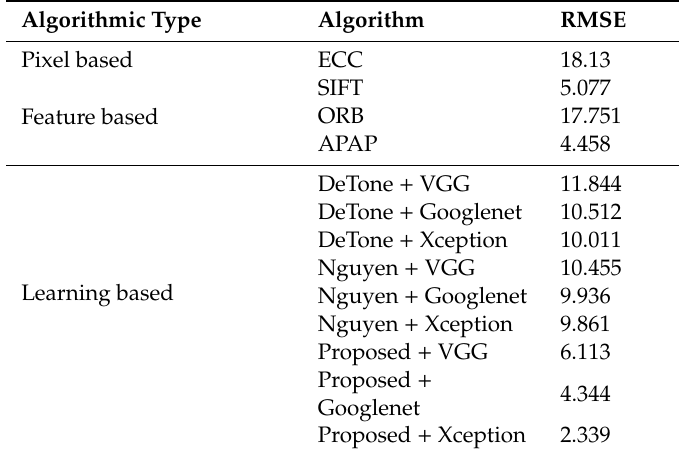
Table 1. RMSE comparison of di ff erent image registration